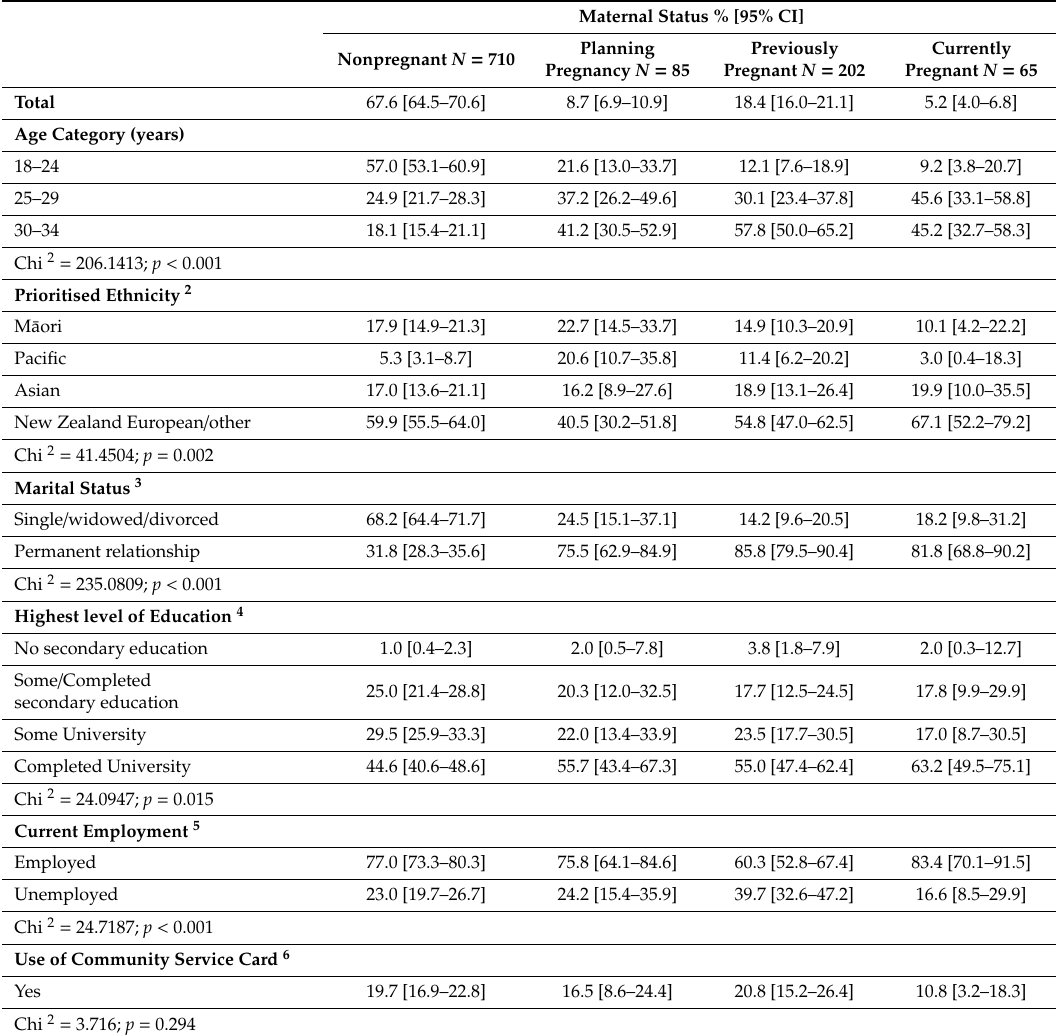
Table 1. Demographic characteristics, alcohol and tobacco consumption and knowledge of alcohol in pregnancy guidelines according to maternal status ( n = 1062) 1